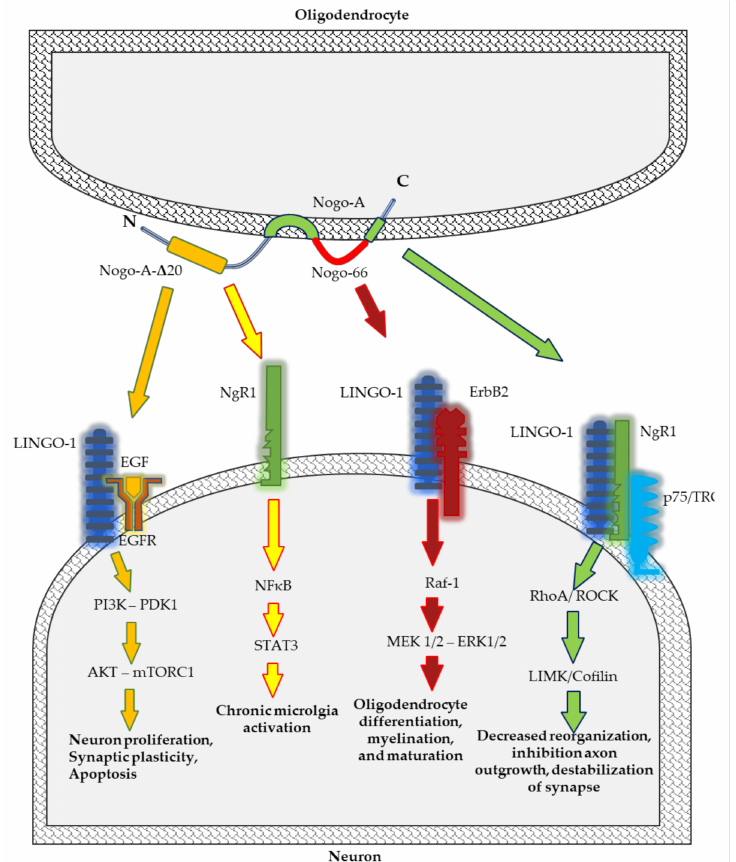
Figure 1. Schematic representation of Nogo-A signalling pathways implicated in neurodegenerative